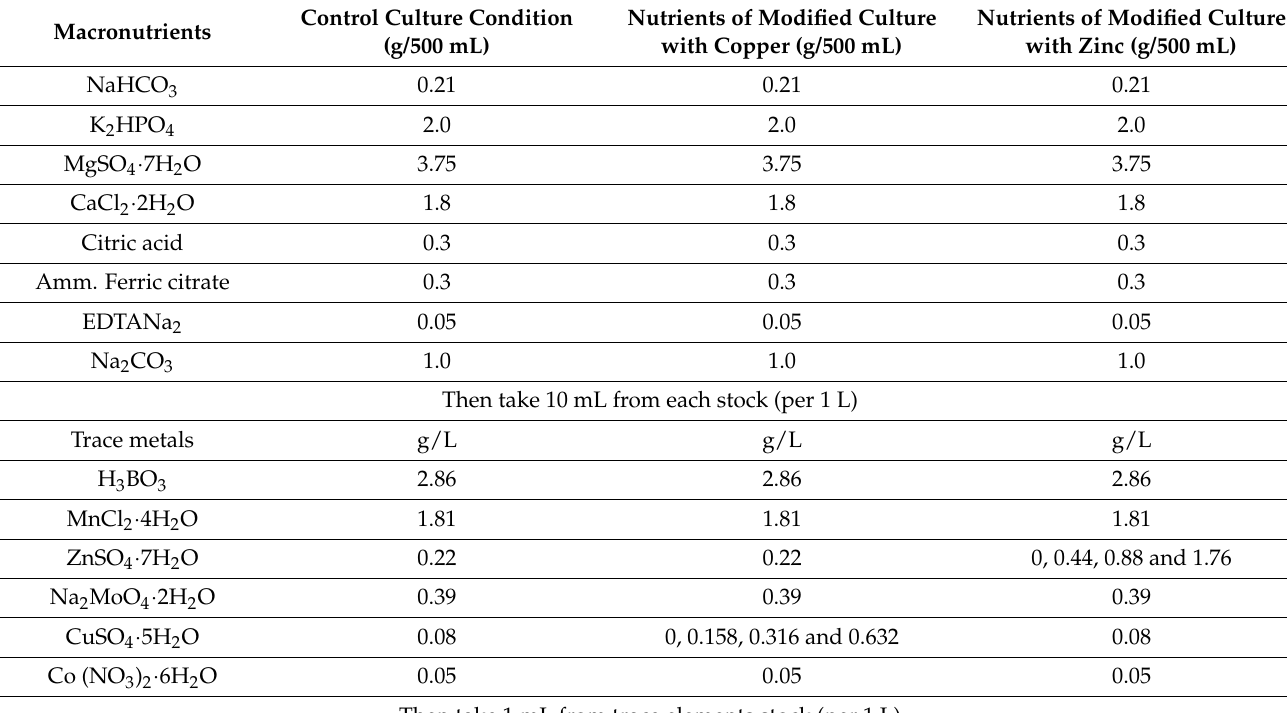
Table 1. Algal culture medium (BG-11 0 ) and its